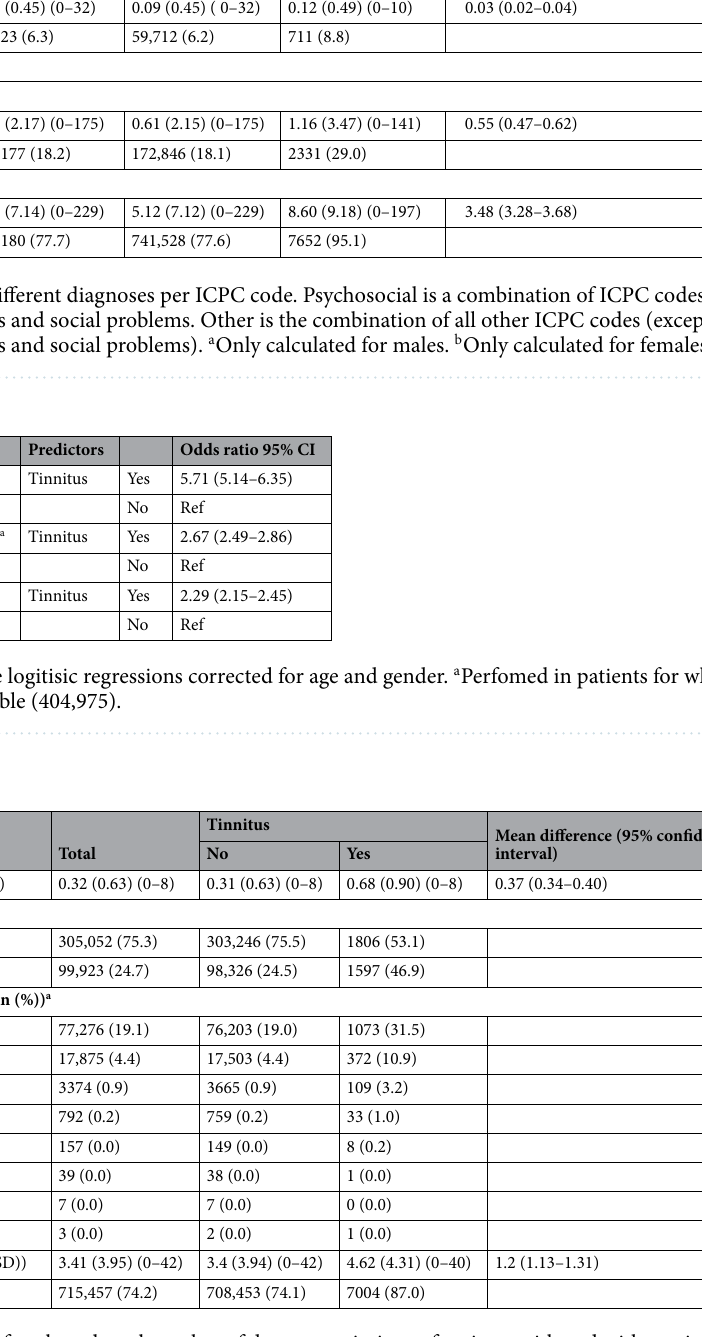
Table 4. Number of referrals and total number of drug prescriptions of patients with and without tinnitus drug. a Assessed in those for whom referral data was available (n = 404,975), available for 401.572 people without tinnitus and 3403 people with